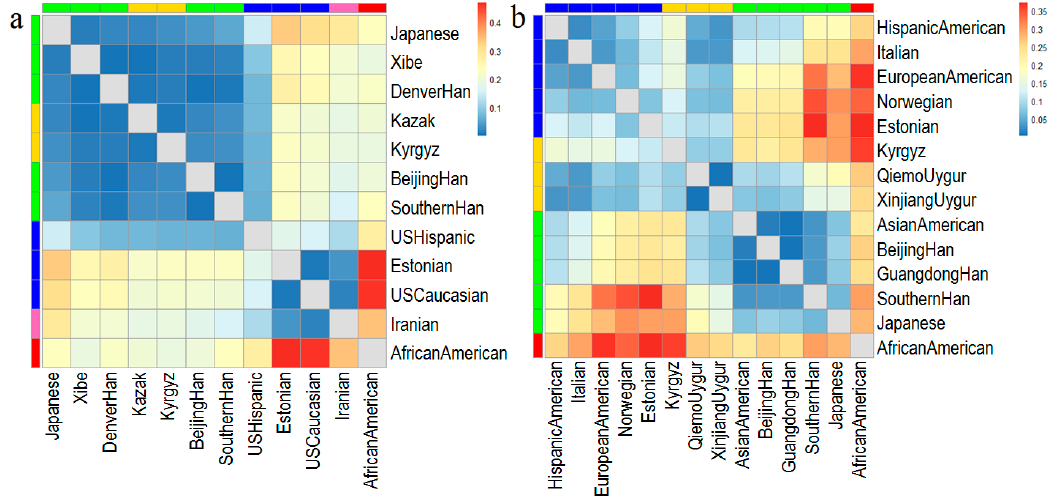
Figure 2. The two heatmaps for genetic distances among the Kyrgyz group and the reference populations, ( a ) pairwise Fst values based on 58 mtDNA SNPs among 12 populations; ( b ) pairwise Rst values based on 23 Y-STRs among 14 populations.